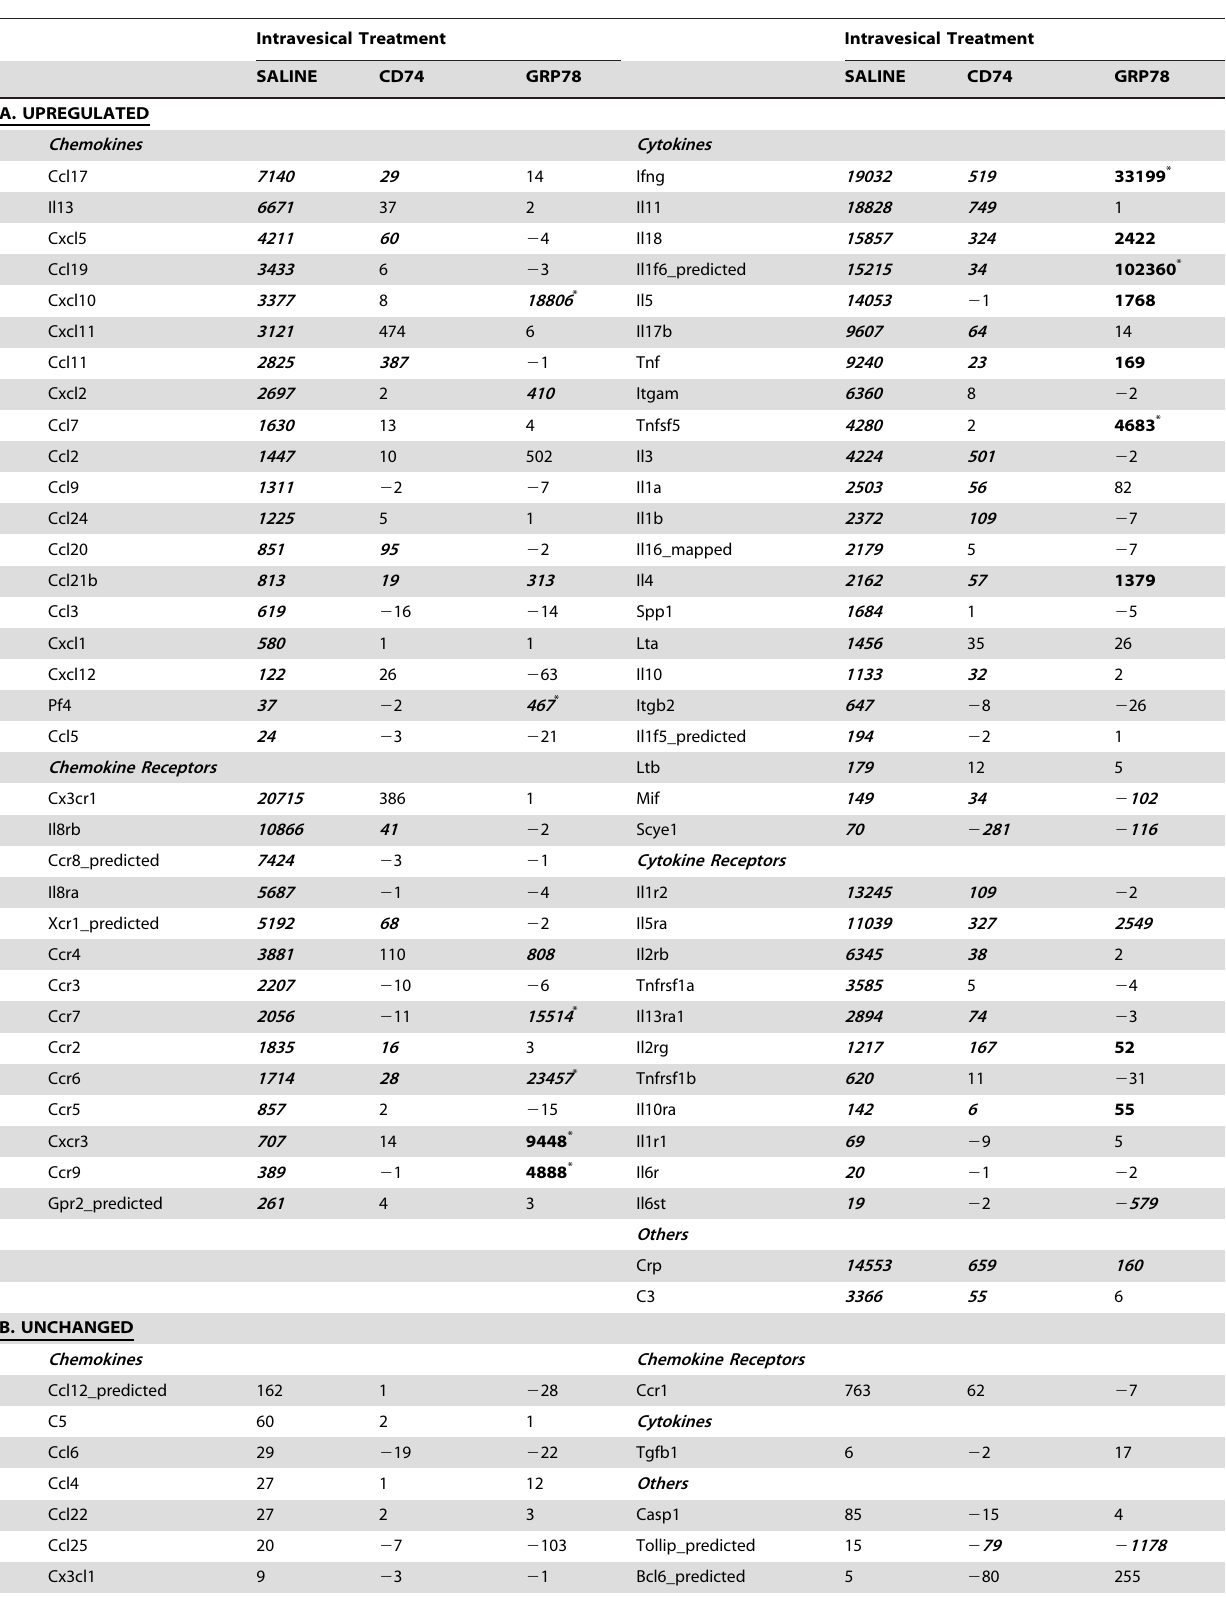
Table 3. Changes in substance P-induced expression of inflammatory markers in urothelial cells as a result intraluminal